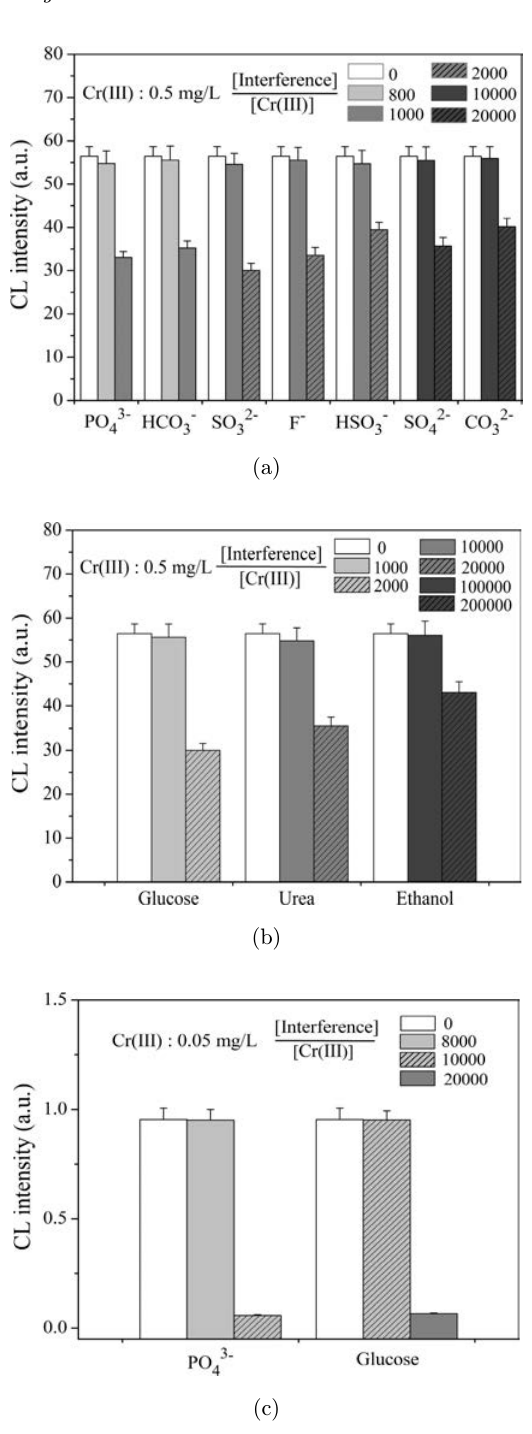
Fig. 8. Investigation of interferences from coexisting anions or organic compounds for Cr(III) determination on the presented devices. In panels (a) – (c), the concentrations of Cr(III) were 0.5, 0.5 and 0.05 mg/L, respectively. Assay